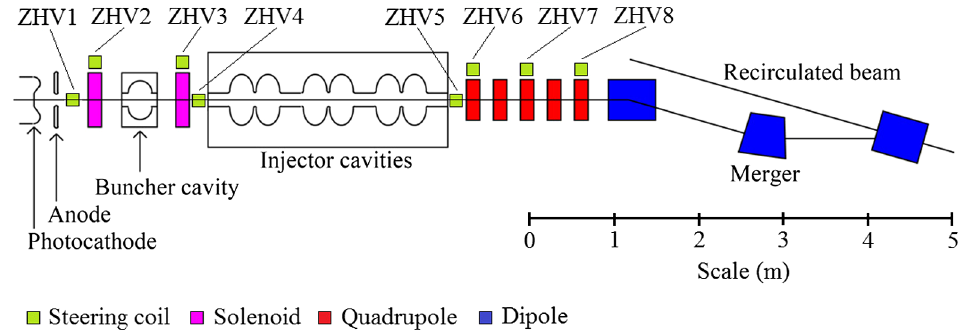
FIG. 18. Layout of steering coils ZHV1 – ZHV8 in cERL injector line (before the main